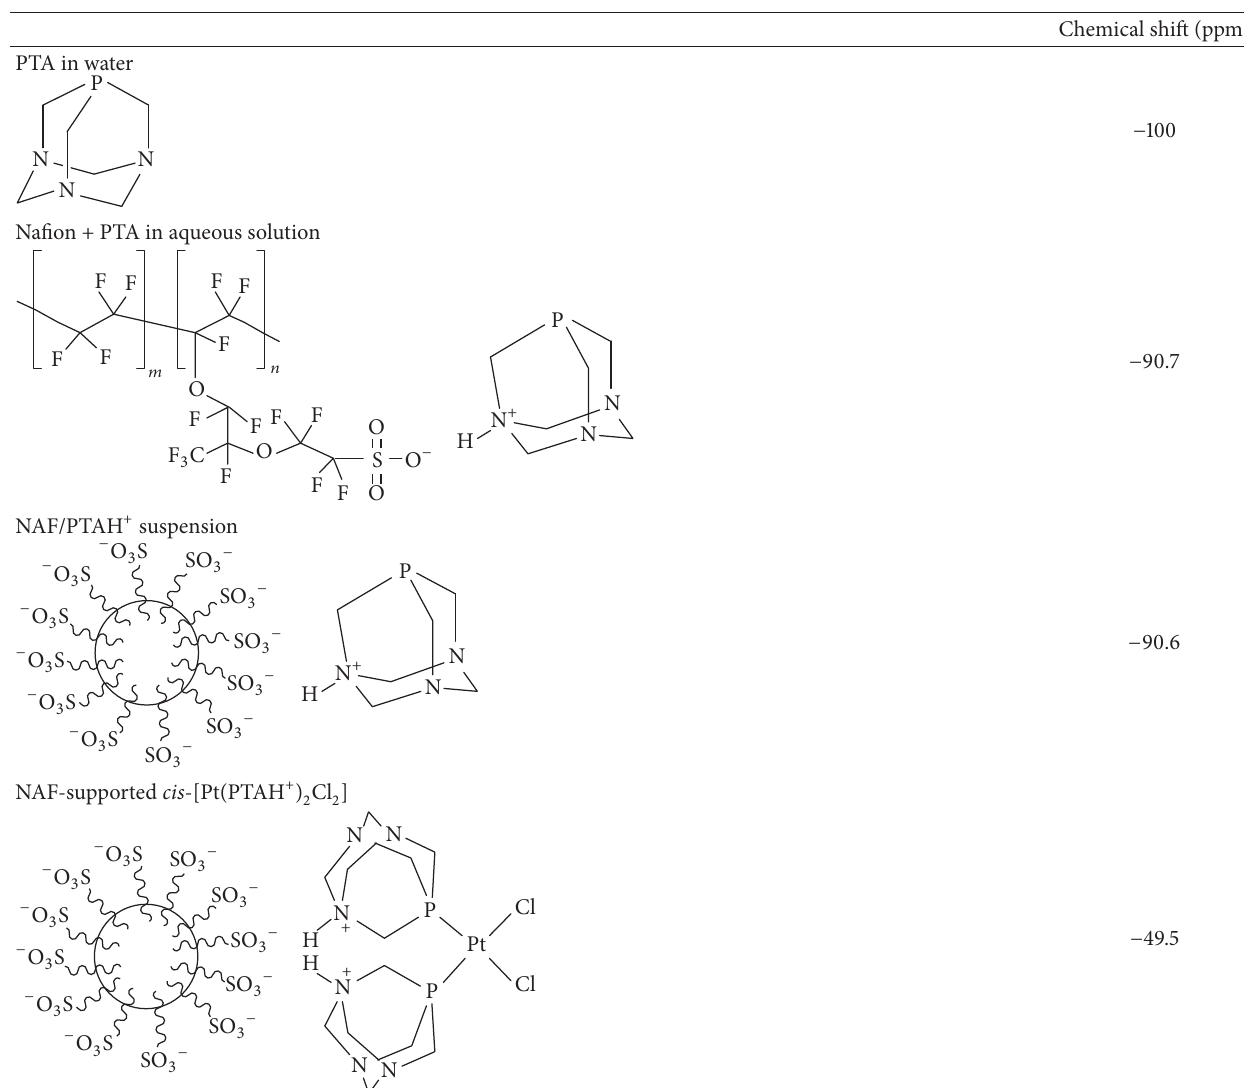
Table 1: 31 P NMR data in D 2